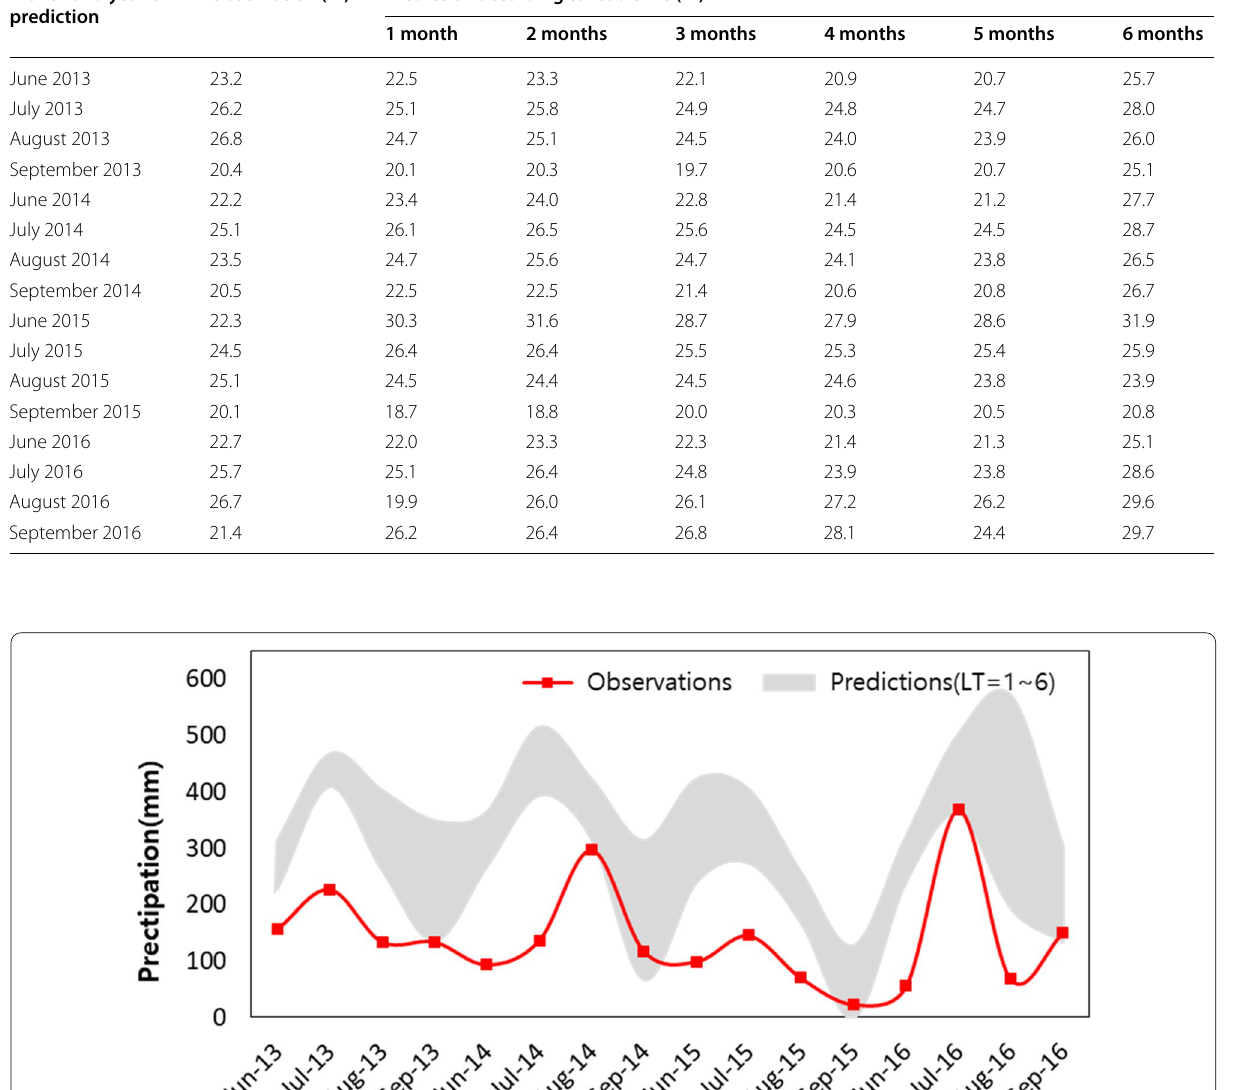
lower NRMSE and MAPE values denote better predictive power. Comparing Figs. 7 and 9, the general method accu- rately predicted the temperature, which corresponds with the observed values, while the modified method overestimated the temperature in some periods. Com- paring the evaluation indicators in Table 12, the pre- dicted results obtained by applying the general model were more accurate than the modified method. For the